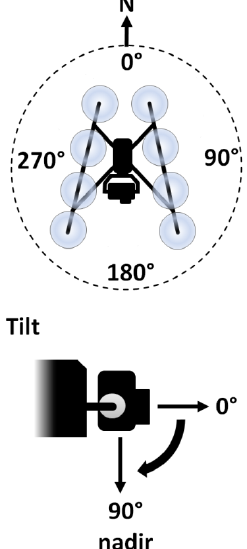
Figure 5. Camera orientation: Heading (azimuth) of the spectral measurements expressed in angular degrees from north. To assume a view angle of 0°, the Unmanned Aerial Vehicle ( UAV ) will hover north of the centeroid and aim the spectrometer at 180°. Tilt: 0° = horizontal and 90° = nadir view.